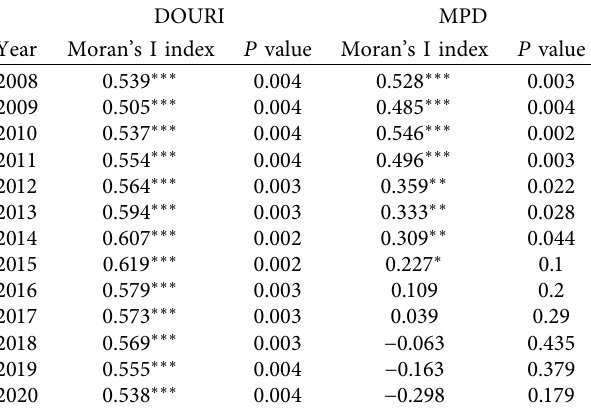
Table 4: Global Moran’s I index